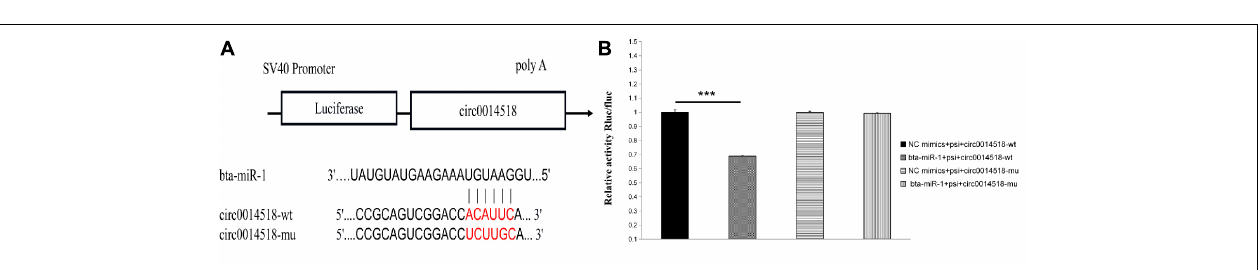
meat production performance and meat quality of the two breeds of cattle after birth, which was also the research basis of this study to explore the underlying molecular regulatory